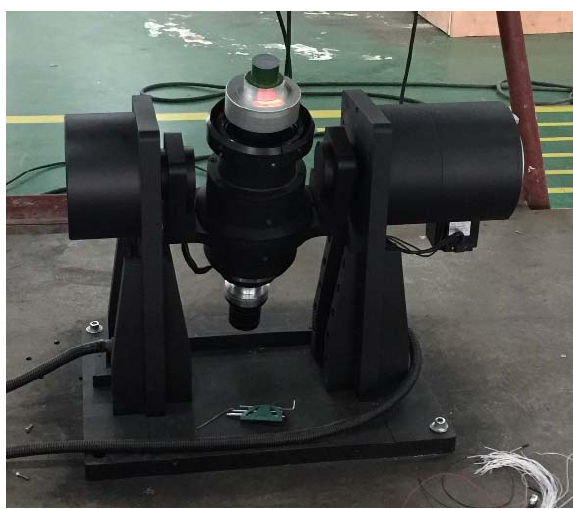
Figure 8. Single ‐ axle rotary table layout of magnetic induction angular rate sensor.